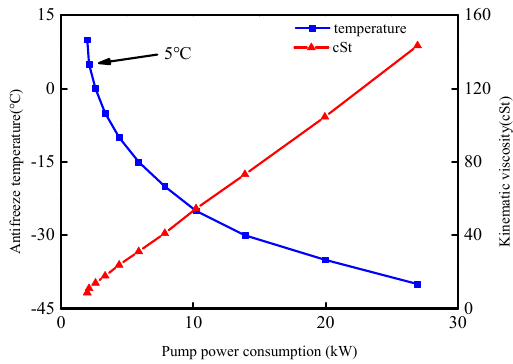
Figure 4. Relationship of pump power consumption and physical parameters.